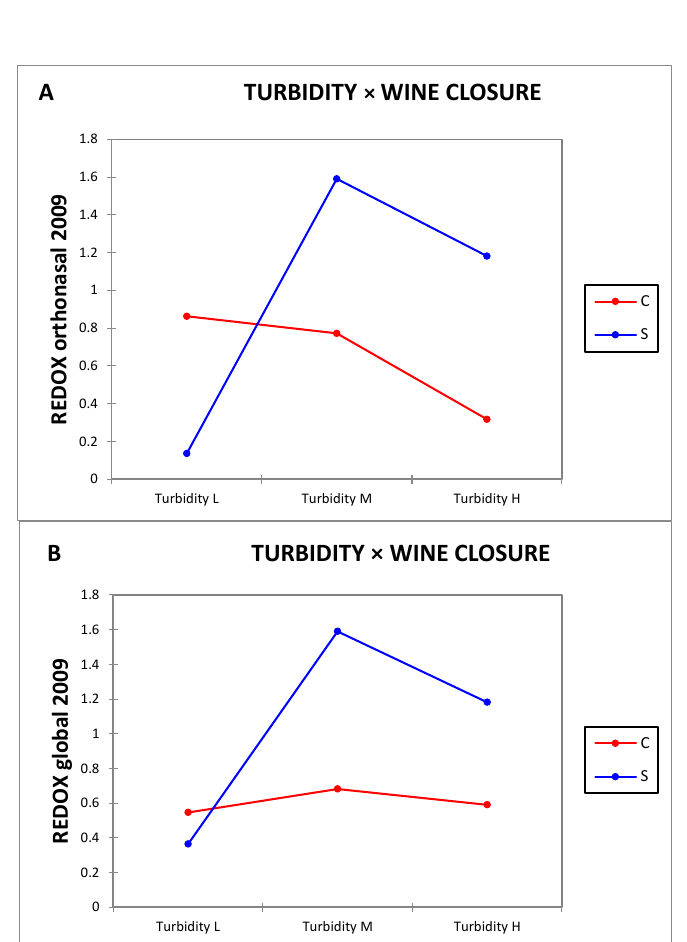
Figure 2. Turbidity*wine closure interaction plots for 2009 data ( A ) orthonasal evaluation and ( B ): global evaluation). S: synthetic coextruded stoppers; C: screw cap stoppers. L: low; M; medium; H: high.